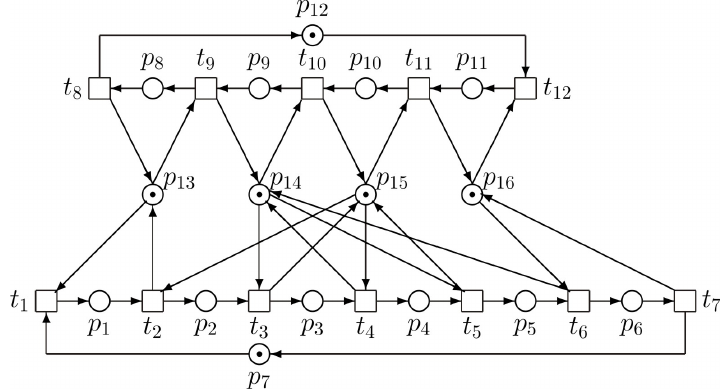
Figure 7. The PN